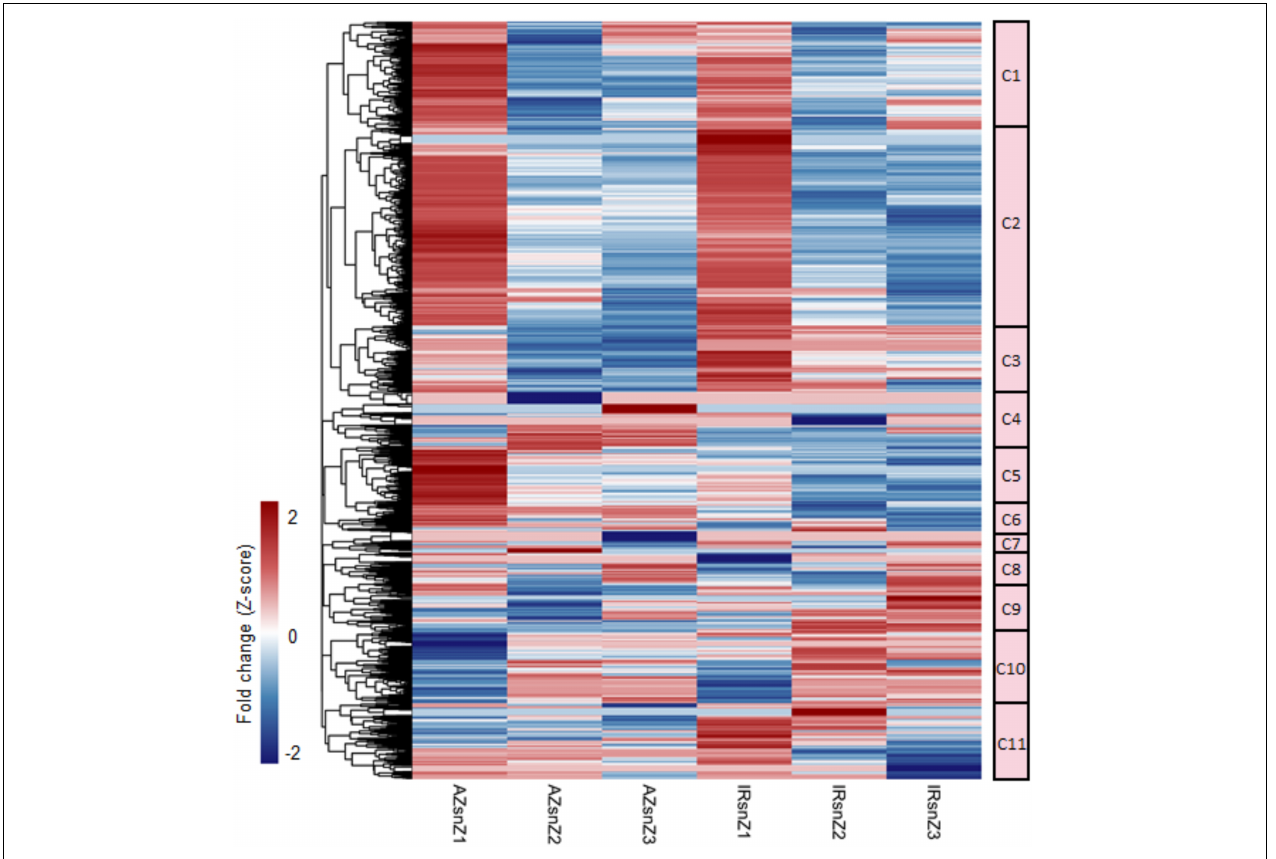
FIGURE 4 | An overview of DEGs and co-expressed clusters across rice genotypes and root zones in response to water stress. Heatmap representing the hierarchical clustering of DEGs based on the fold-change values (clustering method: complete; clustering distance: euclidean). The color bar depicts the gradient of fold changes in response to water stress. The matrix was included the FC values of those genes that were DEG in at least one zone (the non-differentially expressed FC values were set to zero.). The 11 main clusters (C1–C11) were marked. Please see the enriched GO terms belonged to each cluster in Supplementary Table S7